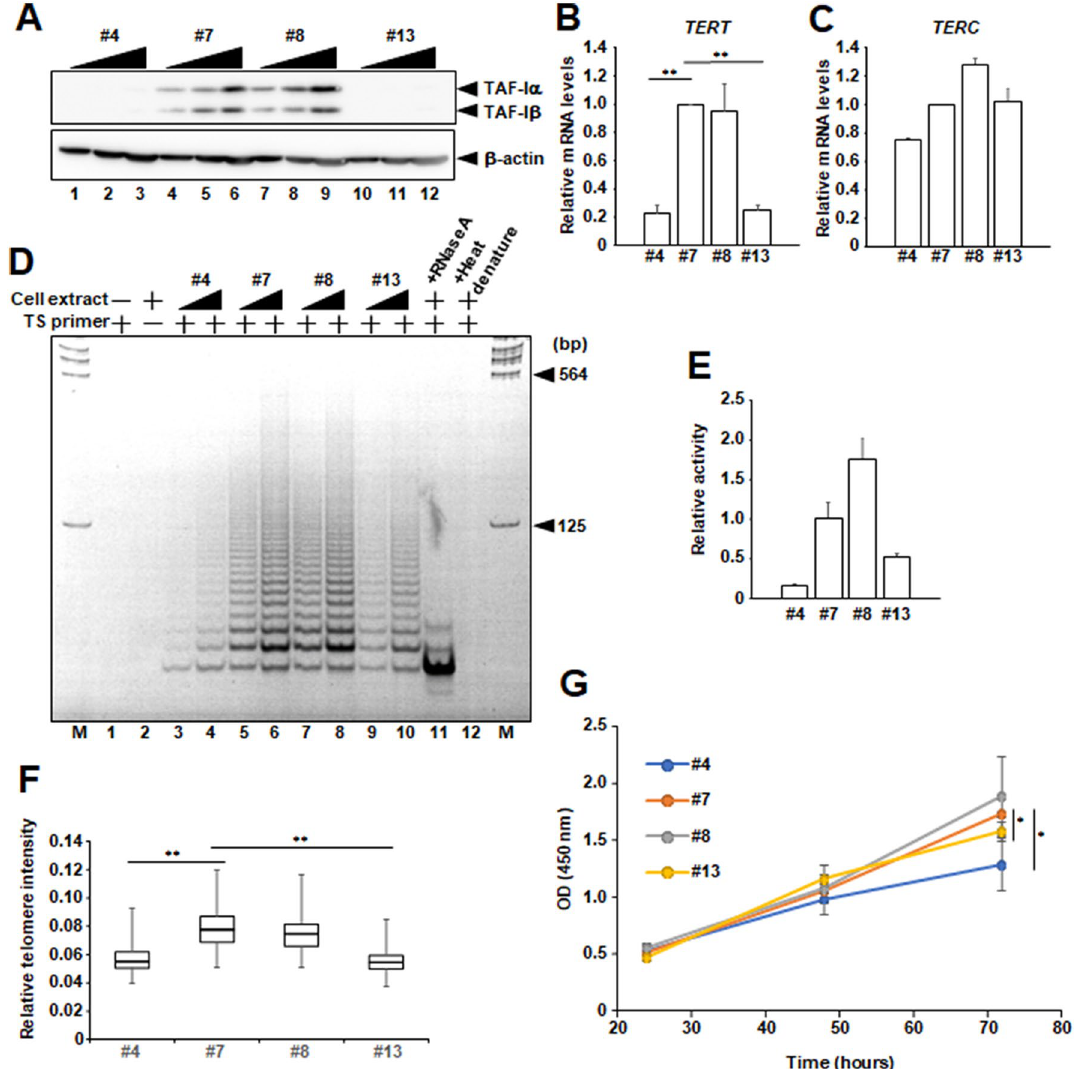
Figure 1. The TERT expression and telomerase activity is downregulated in TAF-I KD HeLa cell lines. ( A ) TAF-Iα and TAF-Iβ expression levels were examined by western blotting analyses. Total cell extracts prepared from WT (#7: lanes 4–6, and #8: lanes 7–9) and TAF-I KD (#4: lanes 1–3, and #13: lanes 10–12) HeLa cell lines were separated on 10% SDS-PAGE followed by western blotting analyses using anti-TAF-Iα/β and anti- β-actin antibodies. Five, ten, and twenty µg of total protein prepared from each cell line was loaded. ( B , C ) The expression level of TERT mRNA and TERC RNA was examined by Q-RT-PCR analyses in each HeLa cell lines. The 18S rRNA was used for normalization as an internal control. Values represent the mean ± SD (n = 3). ** P < 0.01 relative to #7. ( D ) Telomerase activity was examined by TRAP assay. Each cell extract derived from 5.0 × 10 2 cells (lanes 3, 5, 7, and 9) and 2.5 × 10 3 cells (lanes 4, 6, 8, and 10) was incubated as described in “Materials and methods”. Reactions were done without cell extract (lane 1) or TS primer (lane 2) as negative controls. Cell extract pre-treated with RNase A (lane 11) or heat-denatured (lane 12) was used to confirm the telomerase-dependency on reactions. ( E ) Q-TRAP assay. Each cell extract derived from 1.0 × 10 2 cells was incubated in reaction mix and subjected to Q-PCR analyses as described in “Materials and methods”. Values represent the mean ± SD (n = 3). ( F ) Relative telomere intensity of WT and TAF-I KD cells. A value of total telomere intensity in one cell nucleus was normalized by dividing it with a value of total DAPI signal in same cell nucleus, then plotted as a box plot. At least, images of more than 130 cells were taken and analyzed in each cell clone. ** P < 0.01 relative to #7. ( G ) Cell growth assay in HeLa cell lines. The horizontal line indicates time after plating cells, and the vertical line indicates the absorbance at 450 nm after adding WST-8 reagents. Values represent the mean ± SD (n = 3). * P < 0.05 relative to